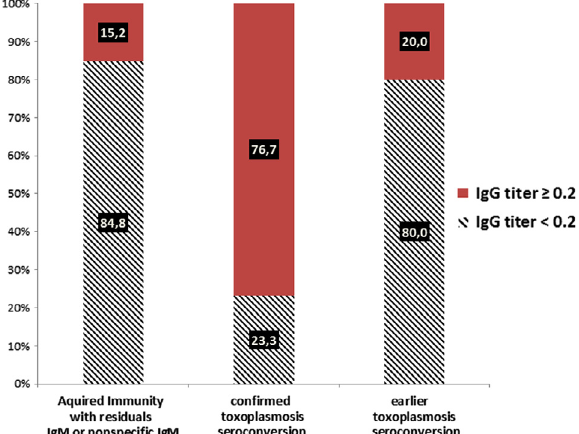
Figure 4. Distribution of toxoplasmosis seroconversion by IgG titer cut-off (cid:2) 0.2 IU/mL for 86 IgG negative (<6 UI/mL) or equivocal (6–9 UI/mL) and IgM positive sera.